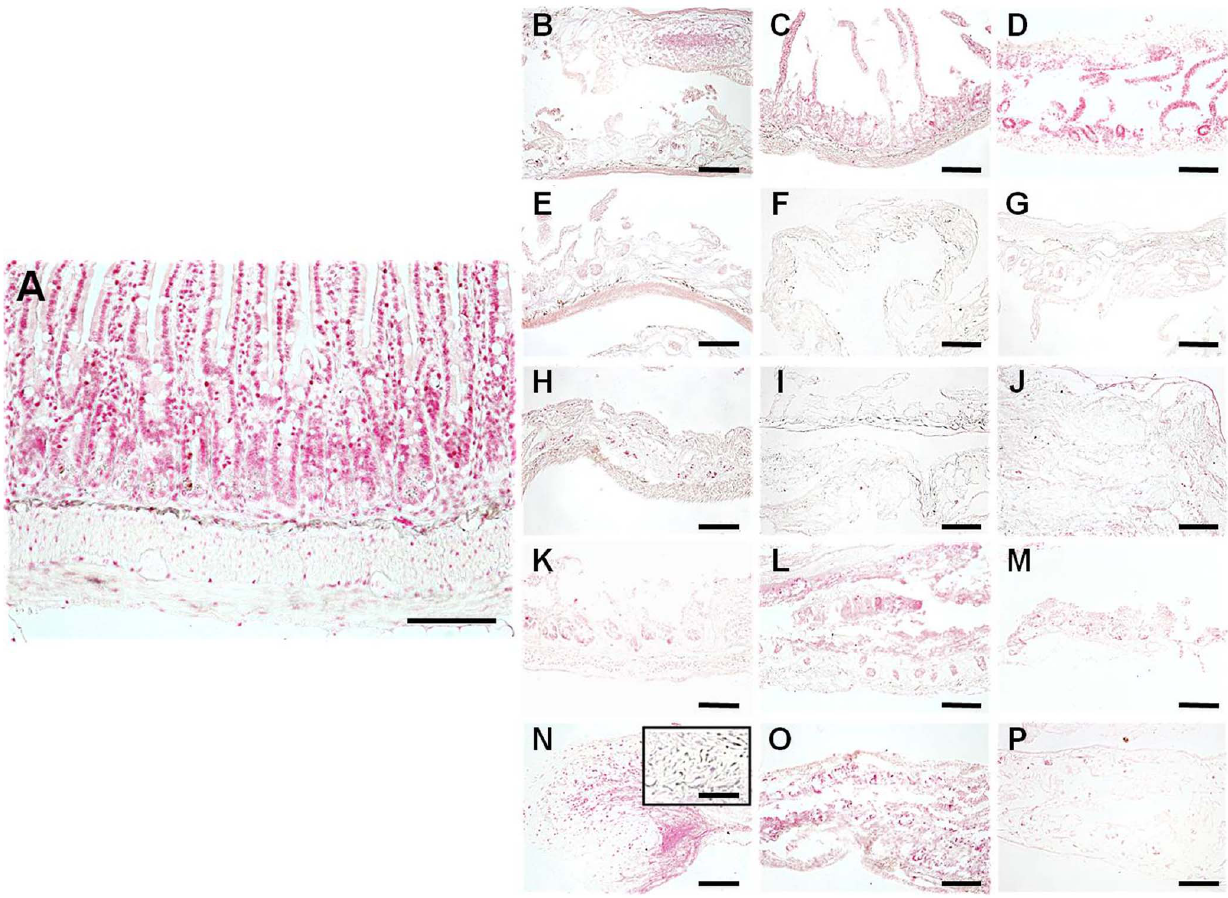
Figure 4. Gomori reticulin staining of control SI samples (A), and tissues decellularized with 1.5 M NaCl (B), 3 M NaCl (C), 5 M NaCl (D), 0.1% SDS (E), 0.3% SDS (F), 0.6% SDS (G), 0.1% triton X-100 (H), 0.3% triton X-100 (I), 0.6% triton X-100 (J), 10 min SC (K), 20 min SC (L), 30 min SC (M), 10 min UV (N), 20 min UV (O) and 30 min UV (P). All scale bars represent 200 m m, with exception of the insert representing a higher magnification image (scale bar=800 m